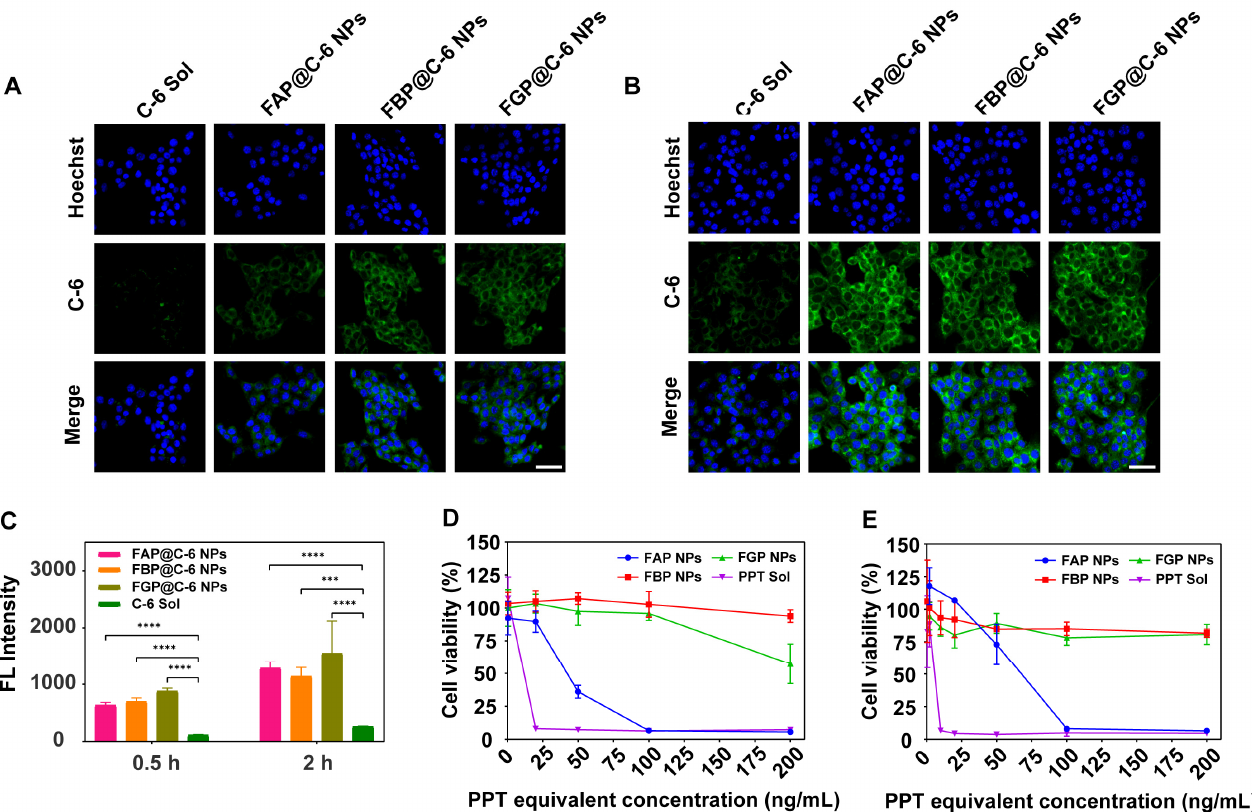
Figure 4. Cellular uptake and cytotoxicity assay (MTT). CLSM images of 4T1 cells incubated with C-6 sol or C-6-labeled prodrug NPs for ( A ) 0.5 and ( B ) 2 h. Scale bar = 50 µ m. ( C ) Cellular uptake in 4T1 cells after incubation with C-6 sol or C-6-labeled prodrug NPs for 0.5 and 2 h via flow cytometry. *** p < 0.001, **** p < 0.0001. Viability of 4T1 cells after treatment with various concentrations of prodrug NPs or PPT sol for ( D ) 48 and ( E ) 72 h. Data are presented as the mean ± SD ( n = 3).